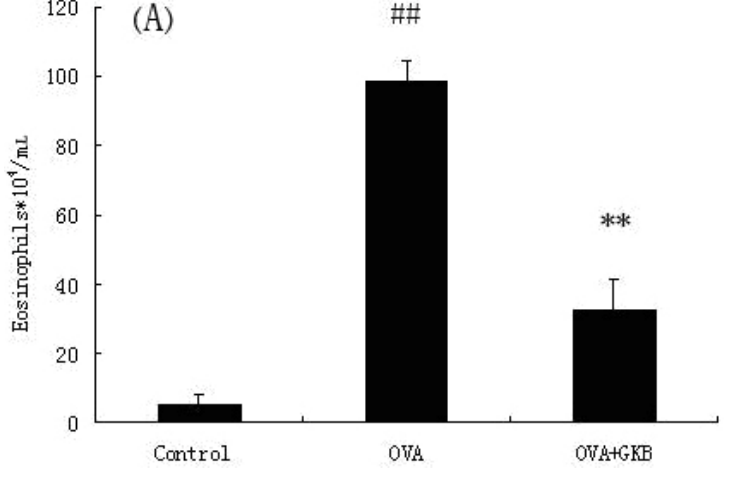
GKB = ginkgolide-B ( ## p < 0.01 vs. control group mice, * p < 0.05, ** p < 0.01 vs. OVA-challenged